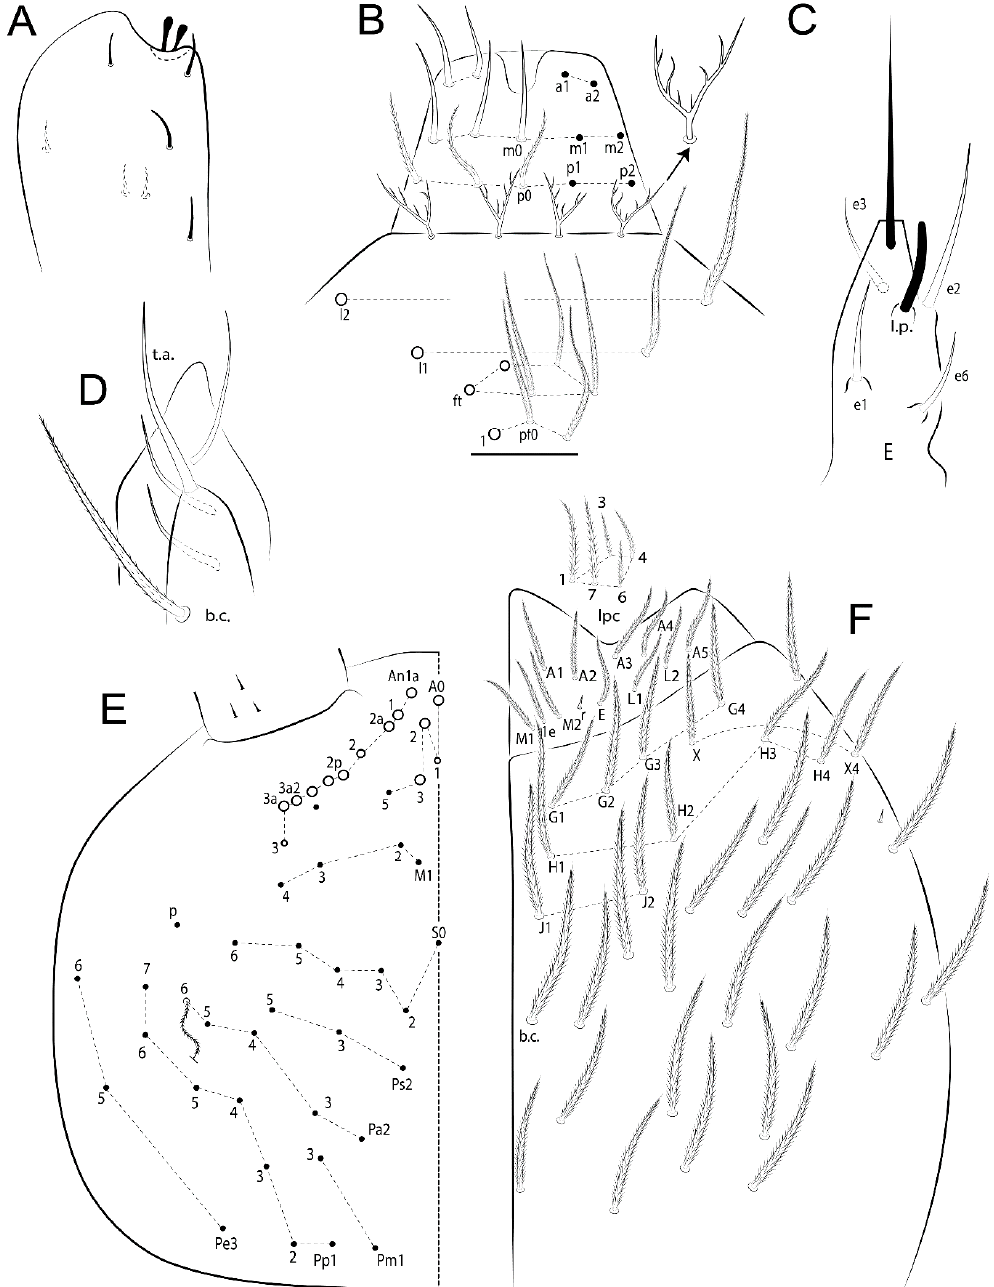
Figure 78. Pseudosinella prelabruscervata sp. nov.: head. ( A ) Ant III apical organ (lateral view); ( B ) chaetotaxy of clypeus, prelabrum, and labrum; ( C ) labial papilla E; ( D ) maxillary palp and sublobal plate (left side); ( E ) head dorsal chaetotaxy (left side); ( F ) labial proximal chaetae, basomedian, and basolateral labial fields and complete postlabial chaetotaxy (right side).